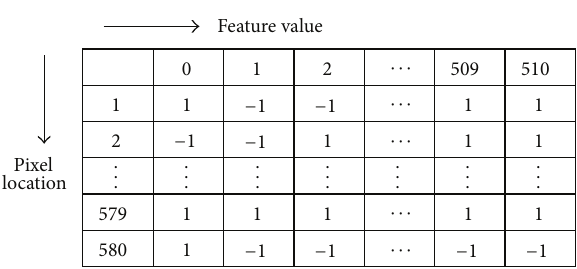
Figure 3: Example of weak classifiers using lookup